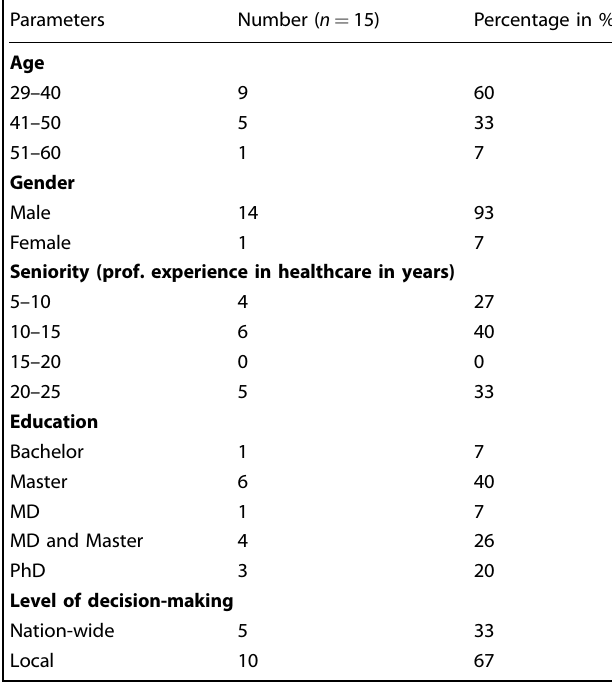
Table 1. Sociodemographic data of participants (Abbreviations: MD Medical doctor, PhD = Doctor of